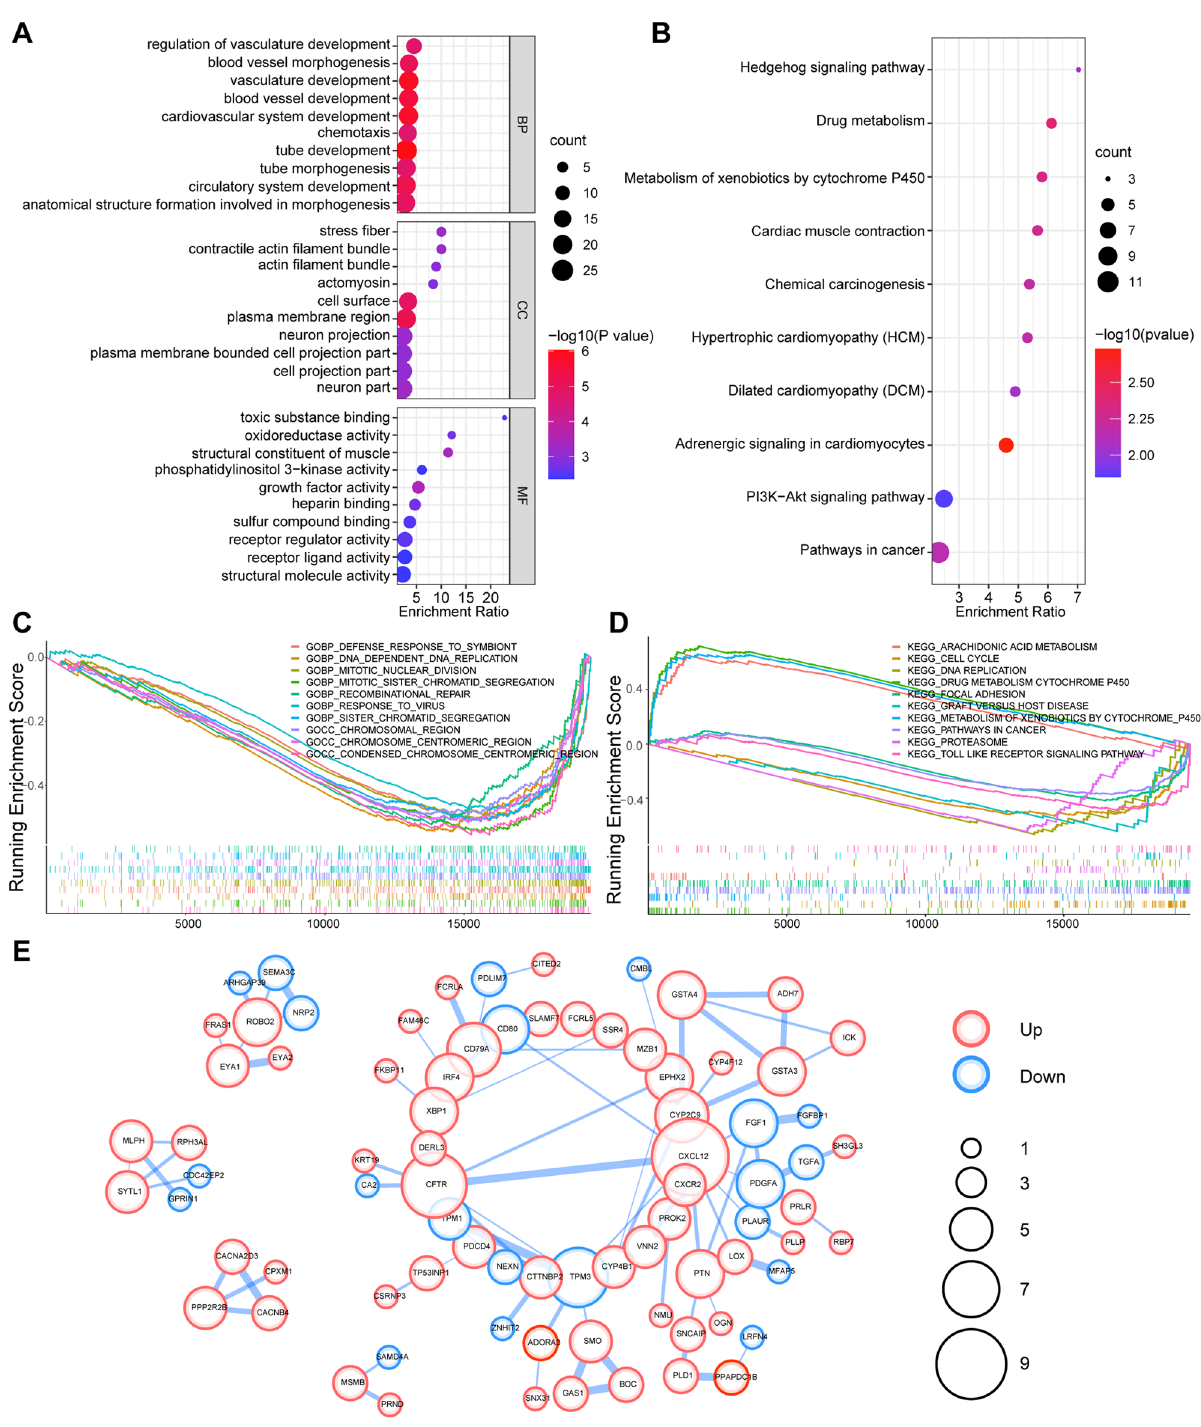
Figure 2. Functional correlation analysis and PPI analysis of DEGs. ( A ) Gene ontology (GO) enrichment analysis of overlapping DEGs. ( B ) KEGG pathways analysis of DEGs. Size of the dots represent Gene Counts, color of the dots are defined by the p -adjusted value. ( C , D ) The top 10 GO terms and KEGG pathways of GSE64216 and GSE23558 from GSEA analysis. ( E ) The PPI network of DEGs using the STRING database. Up- and down-regulated genes were marked in red and blue